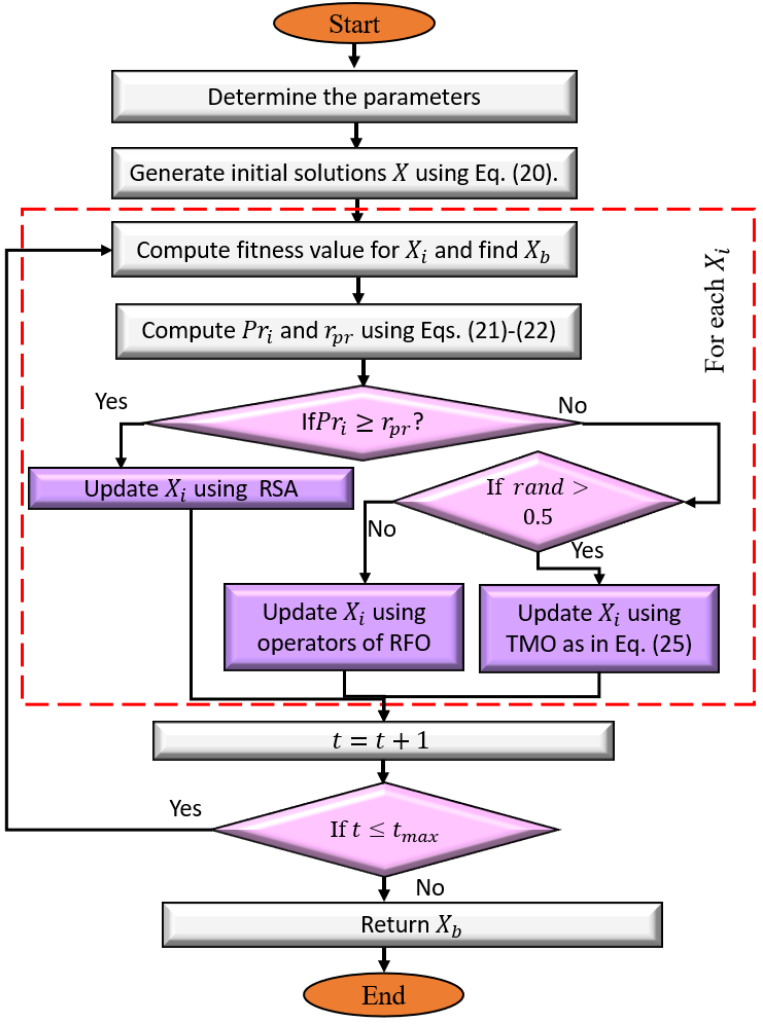
Figure 1. Developed RSRFT